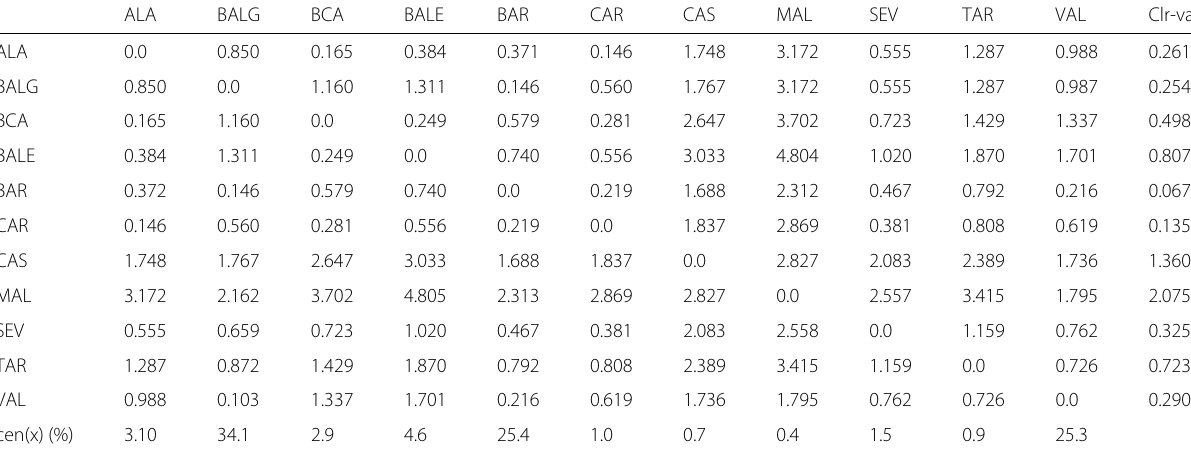
Table 4 Log-ratio normalized variances of the traffic throughput yearly compositions